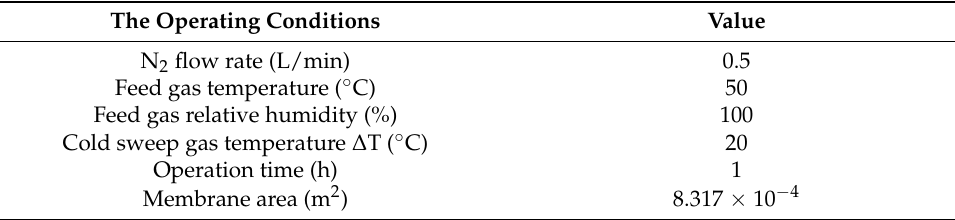
Figure 4. MC device based on the treatment of high-humidity gas. Table 1. The parameters of MC